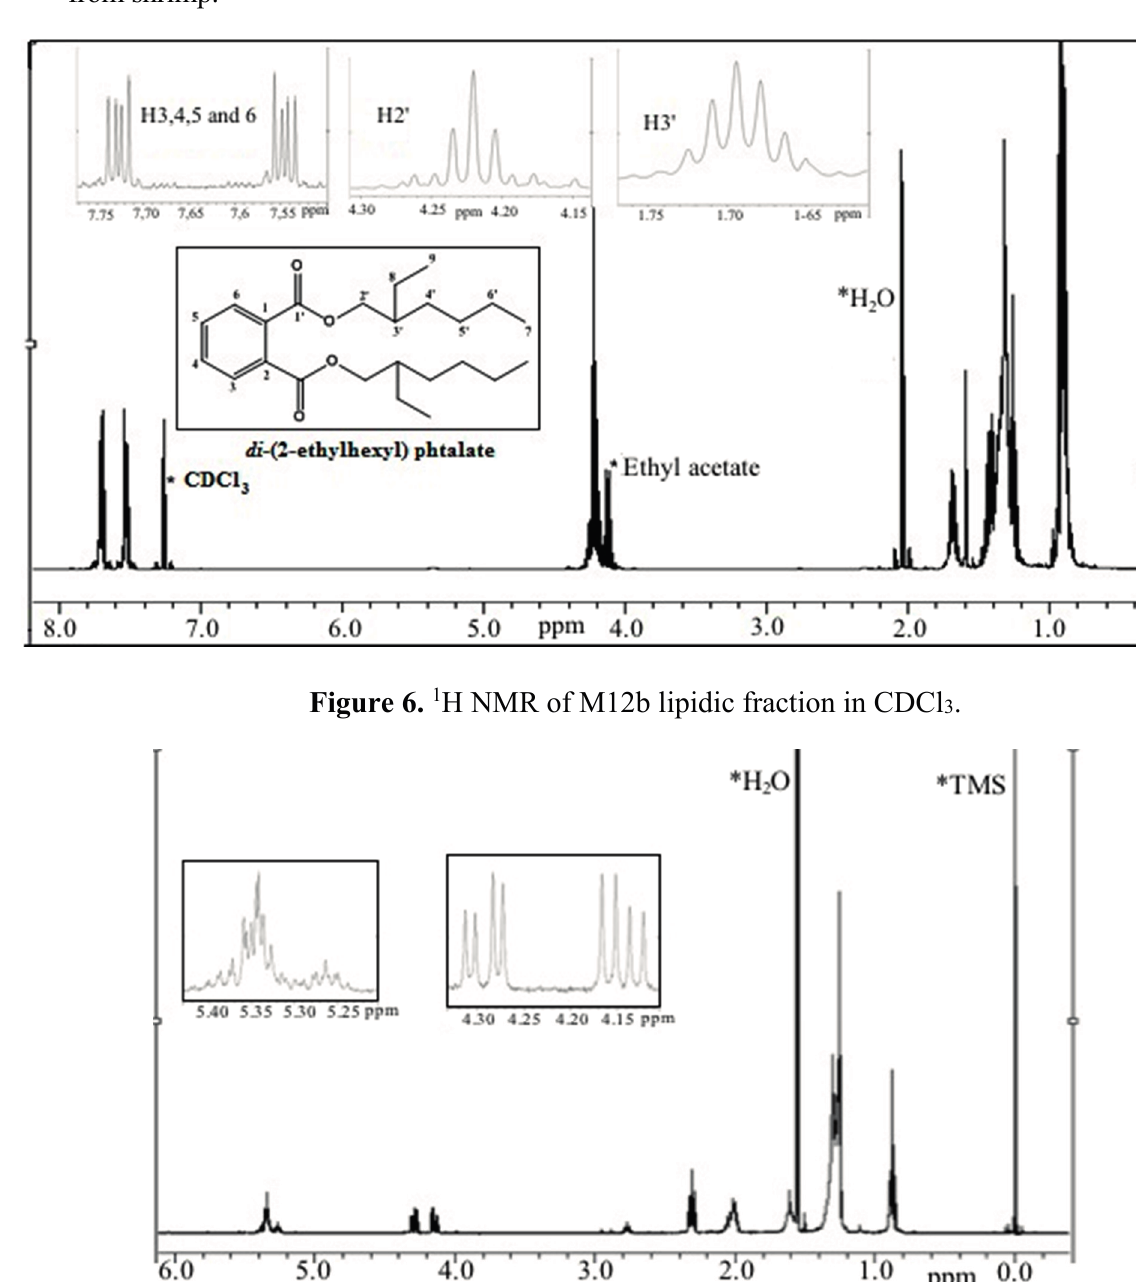
Figure 5. 1 H NMR (in CDCl 3 ) spectra of M12a fraction obtained from lipidic extracts from shrimp.